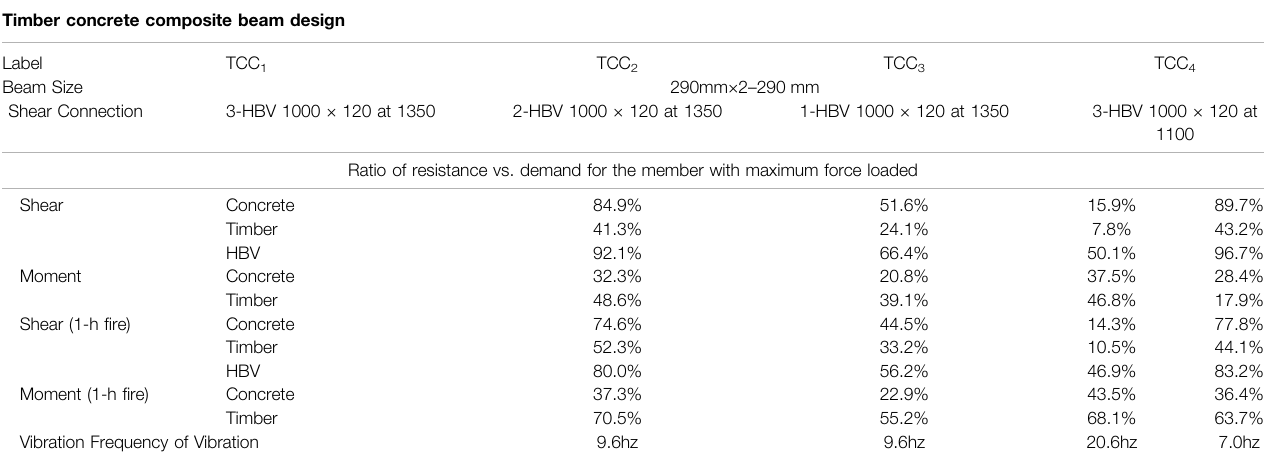
TABLE 3 | Timber concrete composite (TCC) beam design.